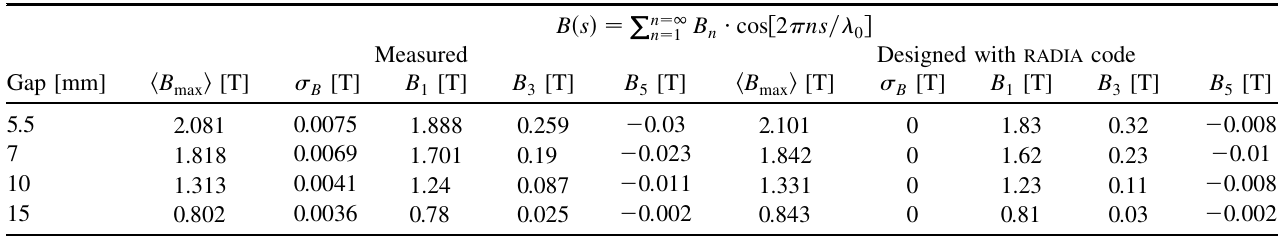
finger is mainly pronounced in the horizontal plane ( I x ). The on-axis field integral has been reduced from 1 : 1 (cid:4) 10 (cid:1) 4 to 10 (cid:1) 5 Tm and the skew integrated quadru- pole component from 0.02 to 0.002 T [Figs. 9(a) and 9(b)]. TABLE VII. First ( B 1 ), third ( B 3 ), fifth ( B 5 ) Fourier components, average peak field h B max i , and peak field dispersion (cid:6) B .